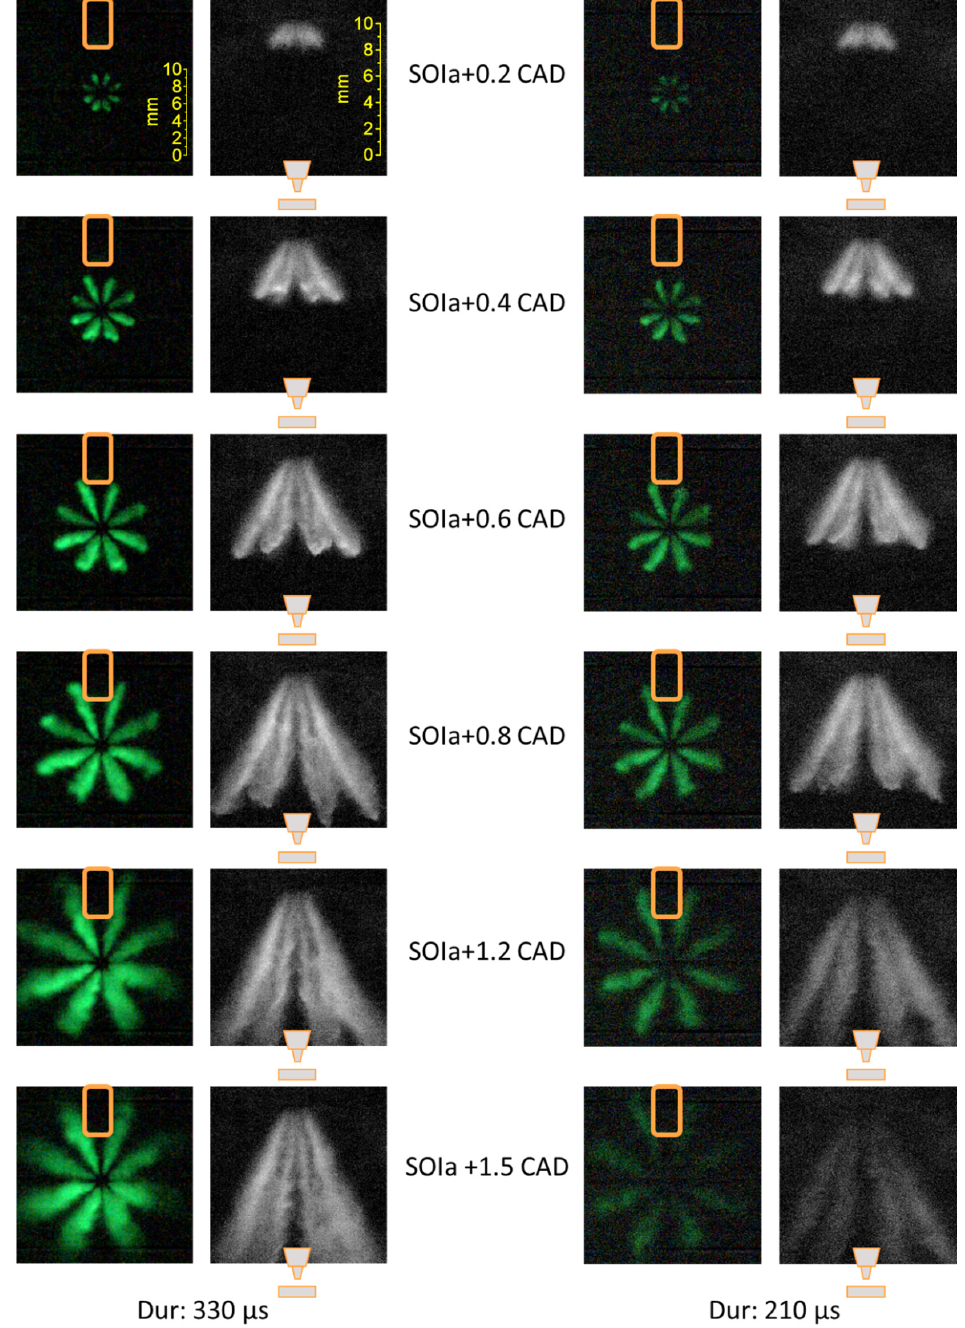
Figure 13. Spray visualization from 0.2 CAD after the start of injection (actual) from bottom and lateral field of view for E30. The outline of the spark electrode is reported in each image.